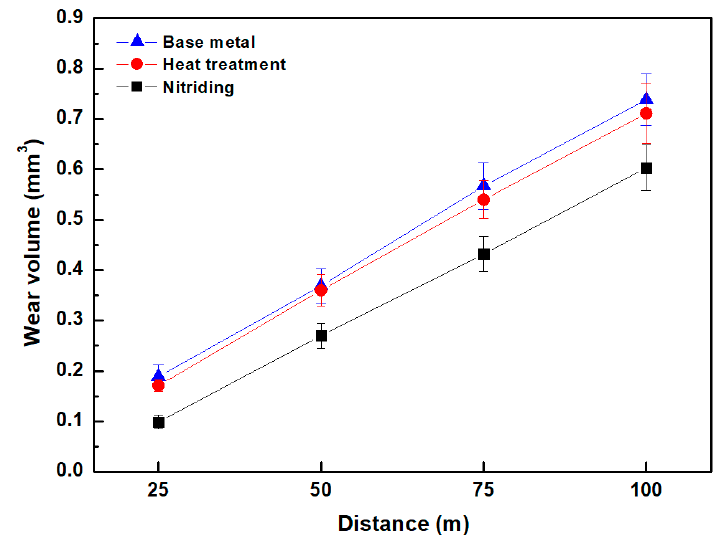
Figure 11. Wear loss of the BM, LH P21, and LN P21 as a function of sliding distance.